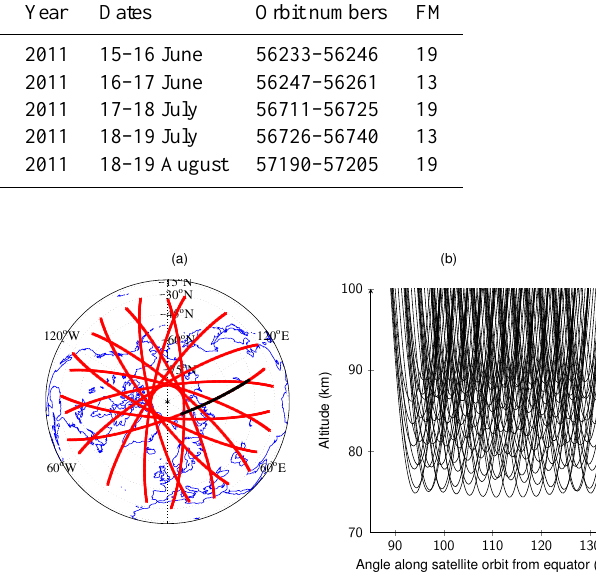
Figure 1. (a) Coverage of SMR tomographic measurements on 16 July 2010. The red points are the tangent positions for each spec- trum. The spectra are processed in batches of 150 spectra, the tan- gent positions for the spectra in one such batch are shown by the black points. (b) The line-of-sight through the atmosphere for the measurements marked by the black points in (a)